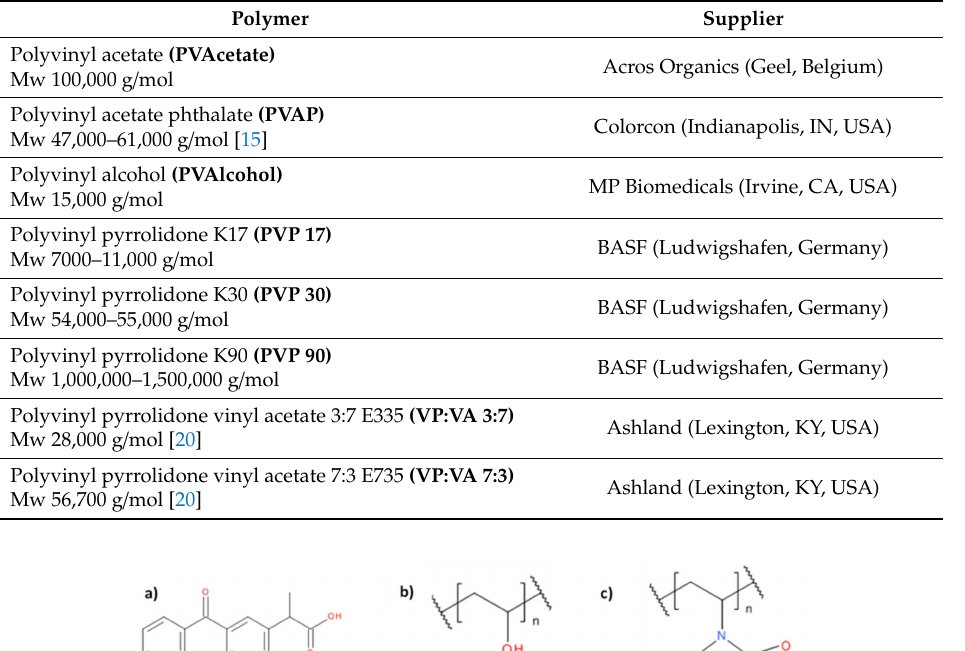
Table 1. Molecular weights and sources of polymers.